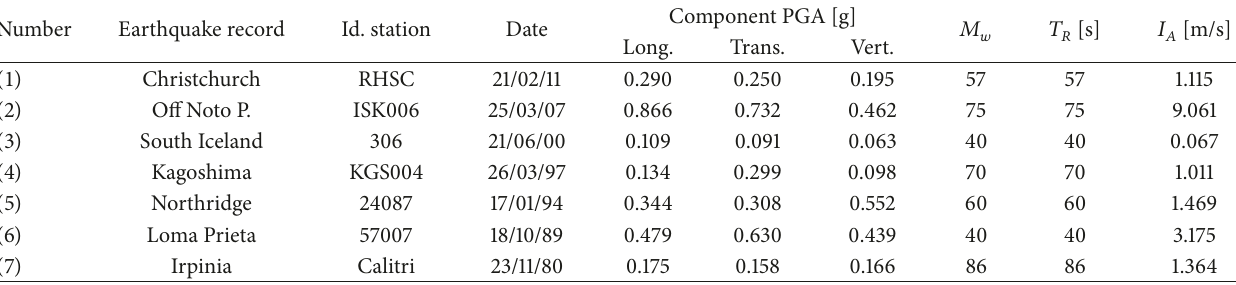
Table 7: Earthquake ground motion parameters.